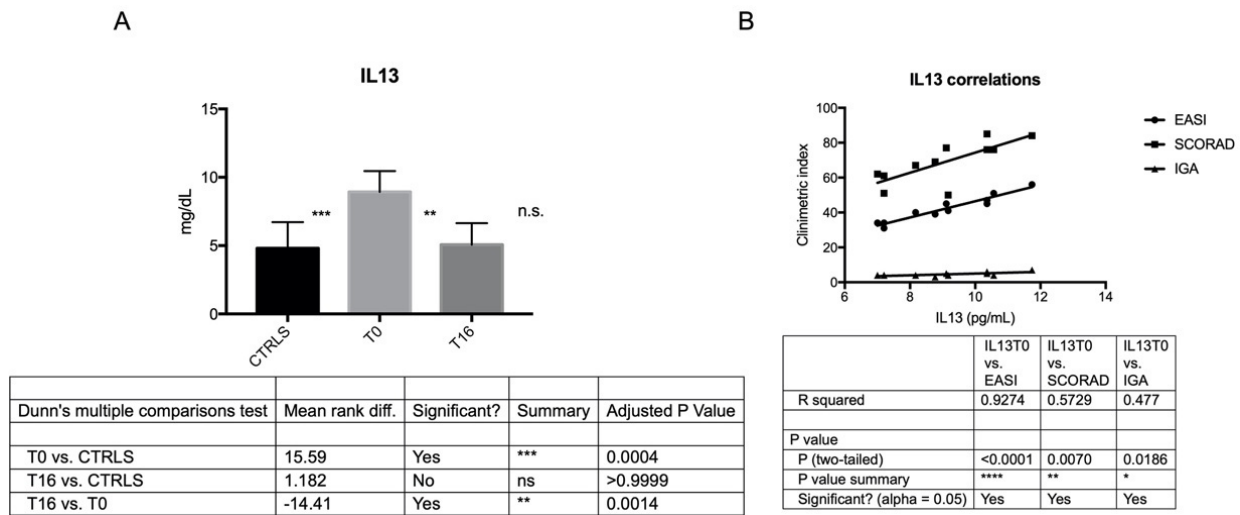
Figure 5. IL13 secretion by C-and AD-MSCs at T0 and T16 and its correlation with AD severity at baseline. ( A ) The histogram depicts the level of secreted IL13 in C-MSCs and in AD-MSCs at T0 and at T16. Secreted protein, evaluated in triplicates by ELISA test, has been reported as pg/mL. ***: p < = 0.0004, AD-MSCs T0 vs. C-MSCs; **: p = 0.0014, AD-MSCs T0 vs. AD-MSCs T16. ( B ) Correlation between IL13 secreted by MSCs at baseline and AD severity according to EASI, SCORAD, and IGA. **** p < 0.0001; ** p = 0.0070; * p = 0.0186. Conversely, IL4 was secreted at lower levels by AD-MSCs than C-MSCs both at T0 and T16 (Table 3). Finally, IL2, IL5, IL10, IL12, IL17A, TNF α , IFNgamma, G-CSF, TGF β 1 were similarly secreted by C- and AD-MSCs (Table